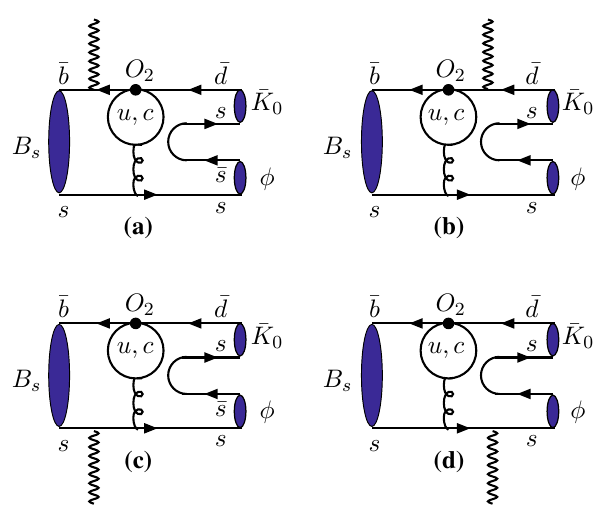
Fig. 3 Feynman diagrams of quark line photon emission. The charm or up loop to the gluon is attached to the spectator quark line. A photon is emitted through the external quark lines